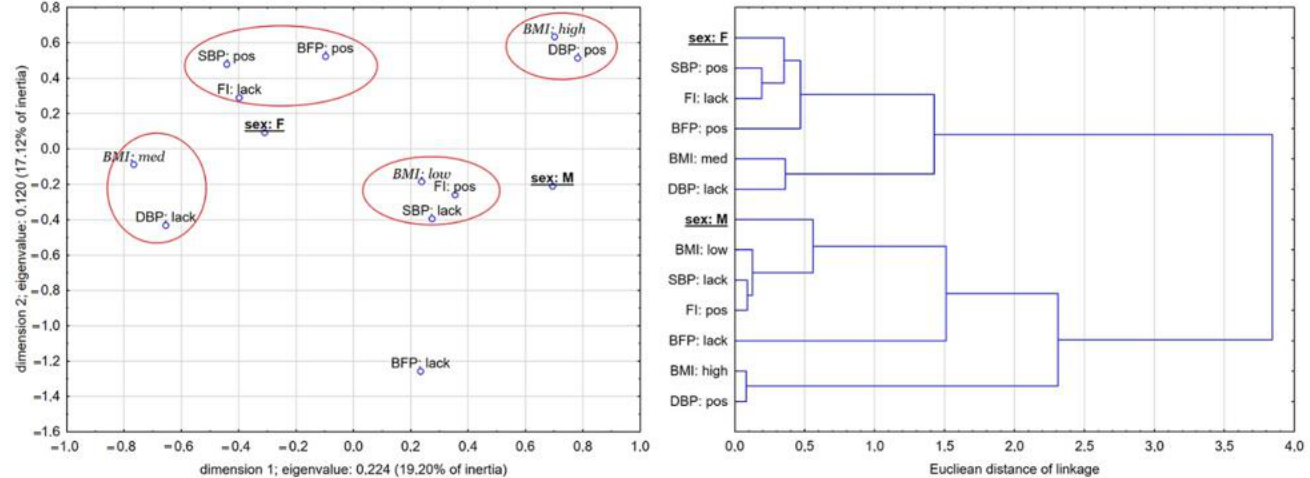
Figure 1. Results of intervention effects on the co-occurrence of changes in independent variables concerning sex and BMI status . Taxonomical dendrogram illustrates similarities and distances (strength) of linkages.